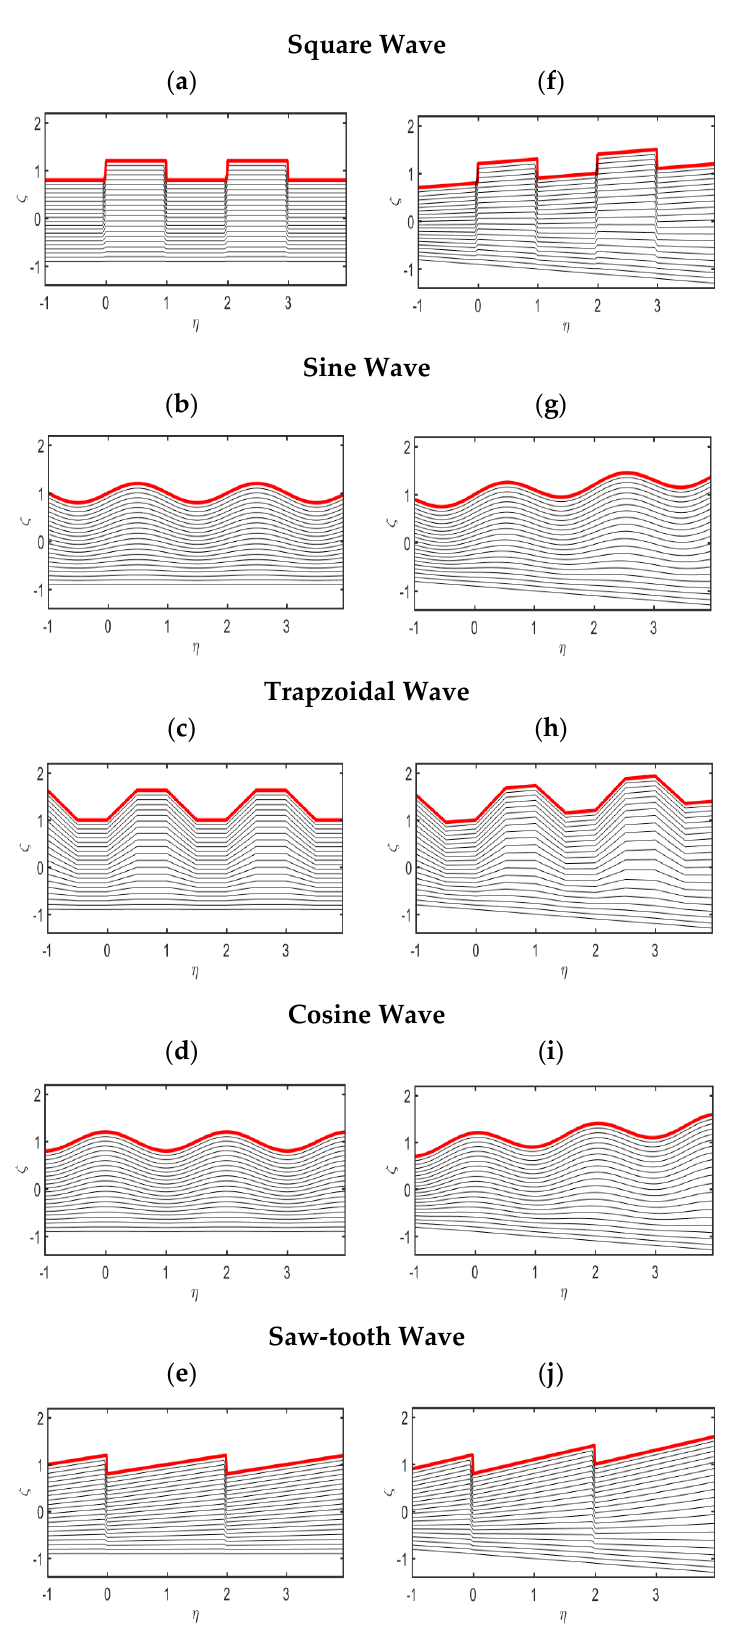
Figure 8. Trapping phenomena for non-uniform parameter (𝛼 = 0,0.1) using ( a , f ) square wave, ( b , g ) sine wave, ( c , h ) trapezoidal wave, ( d , i ) cosine wave, ( e , j ) saw-tooth wave at 𝑞 = −2,𝐷𝐴 = 10,𝛼 = 0.1,𝜎 = 3,and 𝜙 = 0.2.